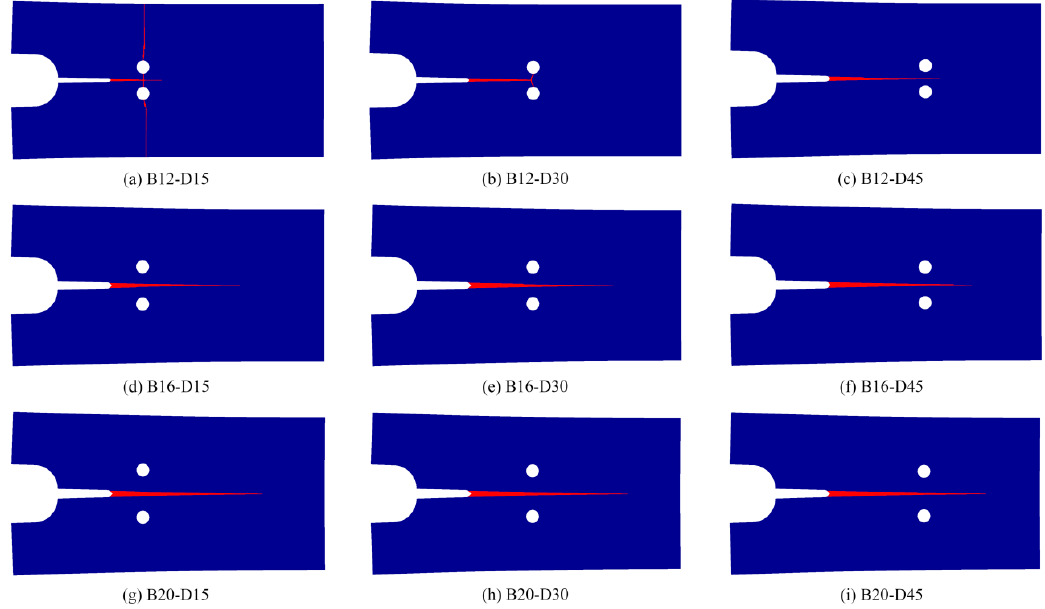
Figure 11. Numerical (AUTODYN) results of crack propagation paths.